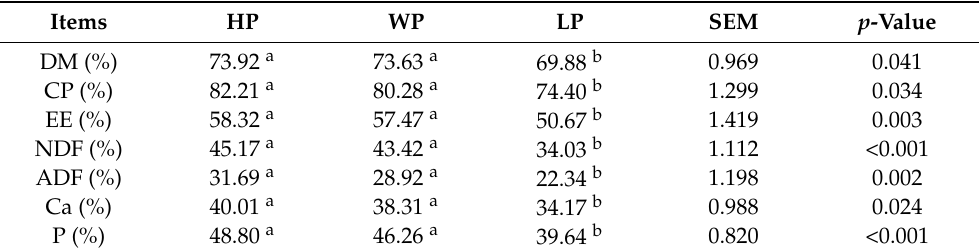
Table 3. Effects of dietary crude protein levels on apparent total-tract nutrient digestibility of lactating